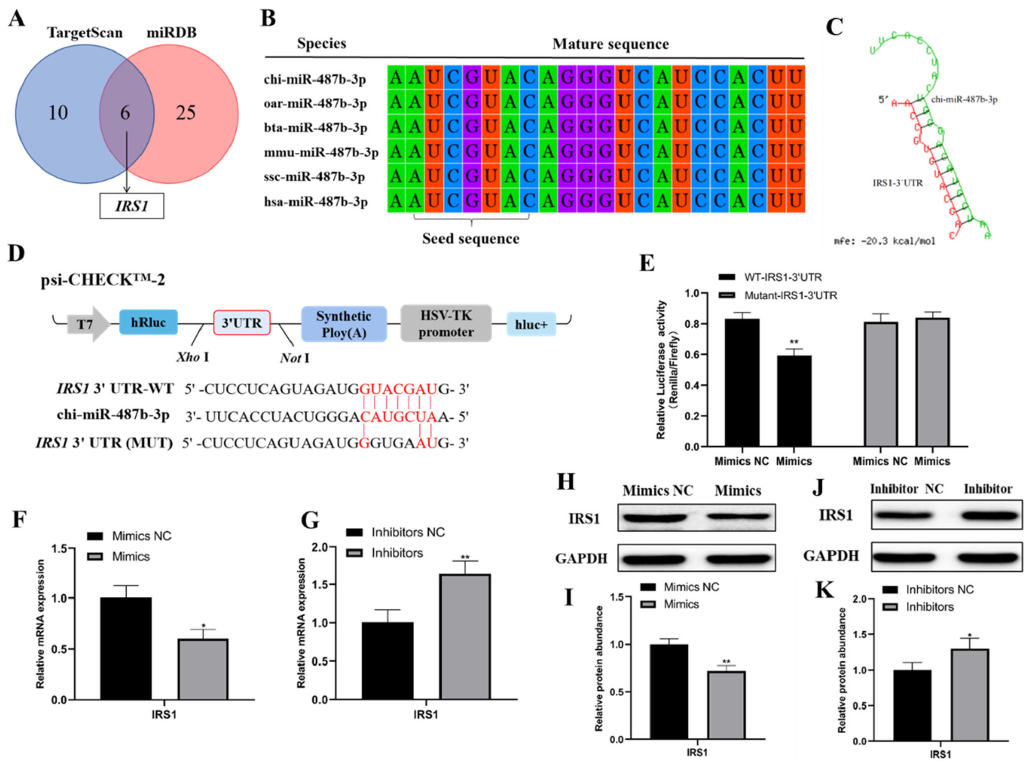
Figure 4. miR-487b-3p directly targets the IRS1 gene. ( A ) miR-487b-3p target genes were Figure 4. miR ‐ 487b ‐ 3p directly targets the IRS1 gene. ( A ) miR ‐ 487b ‐ 3p target genes were explored using the online soft ‐ ware TargetScan and miRDB. ( B ) Comparison of the miR ‐ 487b ‐ 3p sequences from Ovis aries , Bos taurus , Mus musculus , Sus scrofa , and Homo sapiens . ( C ) The RNA duplex structure of miR ‐ 487b ‐ 3p and IRS1 3 ′‐ UTR target site (Red: Target sequence; Green: chi ‐ miR ‐ 487b ‐ 3p). ( D ) The illustration of the dual ‐ luciferase reporter construct with goat IRS1 3 ΄ UTR and the pre ‐ dicted wild type or mutant miR ‐ 487b ‐ 3p binding sites. ( E ) The results of the dual ‐ luciferase reporter assay. Cells were co ‐ transfected with the dual ‐ luciferase reporter containing the wild type (WT) or mutant IRS1 3 ΄ UTR, either with the negative control or miR ‐ 487b ‐ 3p mimics. The activity of renilla luciferase was normalized to firefly luciferase. ( F , G ) IRS1 mRNA expression detected by qRT ‐ PCR in goat myoblasts transfected with miR ‐ 487b ‐ 3p mimics, miR ‐ 487b ‐ 3p inhibitors, or NC. ( H , I ) IRS1 protein expression in goat myoblasts transfected with miR ‐ 487b ‐ 3p mimics or mimics NC. ( J , K ) IRS1 protein expression in goat myoblasts transfected with miR ‐ 487b ‐ 3p inhibitors or inhibitors NC. Data are shown by mean ± SEM of three independent experiments. * p < 0.05; ** p < 0.01. 2.5. IRS1 Knockdown Suppresses Goat Myoblast Proliferation and Differentiation We further examined the role of IRS1 during goat myoblast proliferation and differ ‐ entiation by RNA interference. First, we found that the IRS1 gene is highly expressed in lamb ‐ stage muscle tissues (Figure 5A) and has the opposite expression profiles during myoblast proliferating and differentiation (Figure 5B,C). The optimal siRNA transfection concentration in goat myoblasts was 100 nM, and siIRS1 demonstrated the best knock ‐ down efficiency ( p < 0.01; Figure 5D). Cell proliferation was detected by CCK ‐ 8 and EdU staining analysis. We found that IRS1 knockdown significantly inhibited goat myoblast proliferation (Figure 5E–G). Furthermore, IRS1 knockdown resulted in significant changes in the expression of cell cycle ‐ related genes ( PCNA , CDK2 , and p27 ) at both mRNA and protein levels (Figure 5H–J). In addition, we also detected the effect of IRS1